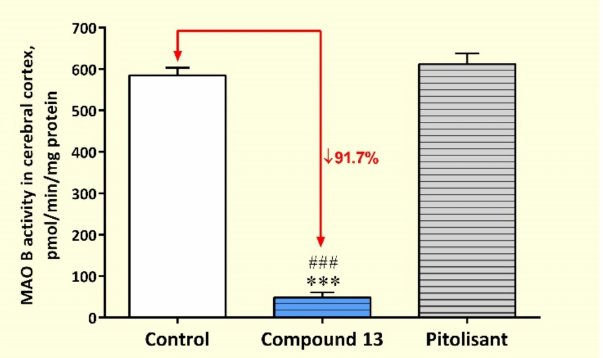
Figure 8. Effects of sub-chronic administration of compound 13 and pitolisant on rat brain MAO B activity. Values are means ± SEM for 8 rats. One-way ANOVA and Tukey’s multiple comparisons test: *** vs. control, ### vs. pitolisant, p < 0.001.